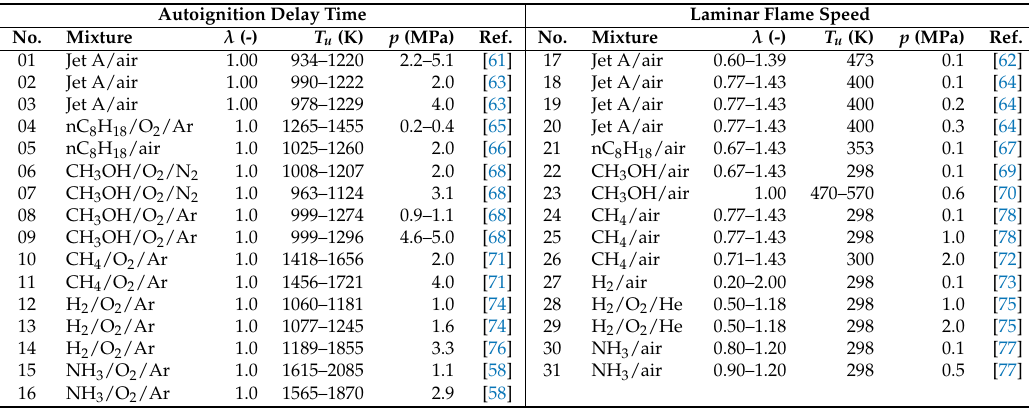
Table 3. Experimental data from the literature used in this